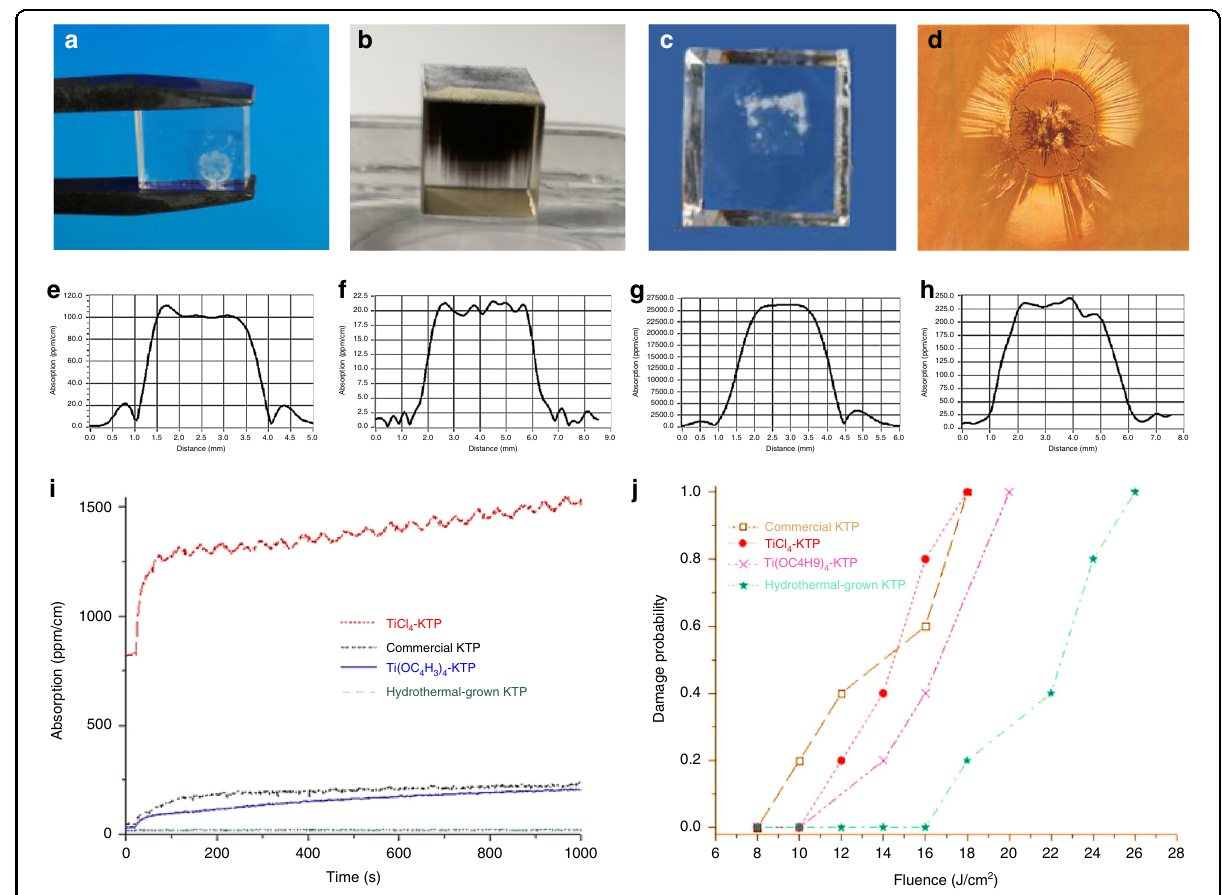
Fig. 9 Damage resistance of KTP. Photograph of F-KTP under the 300 V·mm – 1 electric fi eld a after 10 min, b after 30 min, and c H-KTP. under the 1000 V·mm – 1 after 72 h. d Microscope image of the catastrophic damage by laser. Bulk weak absorption values of e F-KTP and f H-KTP crystals at 1064 nm, g F-KTP, and h H-KTP crystals at 532 nm 95 ; i Relaxation time of green induced infrared absorption: F-KTP (red line) and H-KTP crystals (green line) 95 ; j Surface LIDT of the KTP samples at 1064 nm: F-KTP (black square) and H-KTP crystals (green pentagram) 95 . Fig e – j , reprinted with